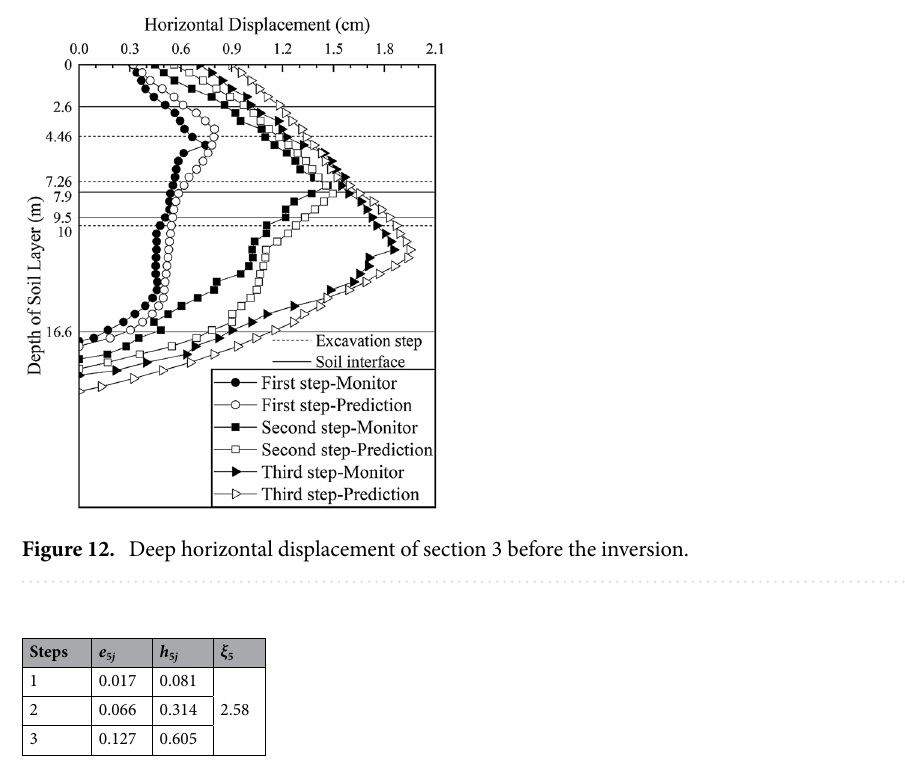
Table 7. Section 3 calculation